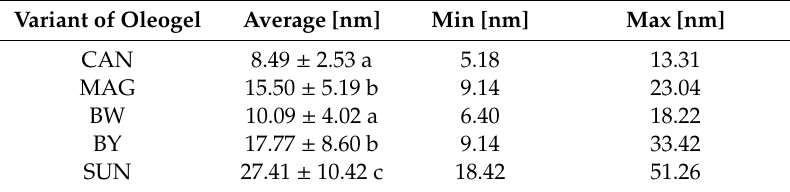
Figure 4. The structure of oleogels in the microscopic image at 600× magnification, obtained by polarization ( images at the top-1 ) and bright field ( images at the bottom-2 ). Table 4. Average, minimum (min), and maximum (max) length of oleogels crystals, seeing in polarized microscopy in 600 ×